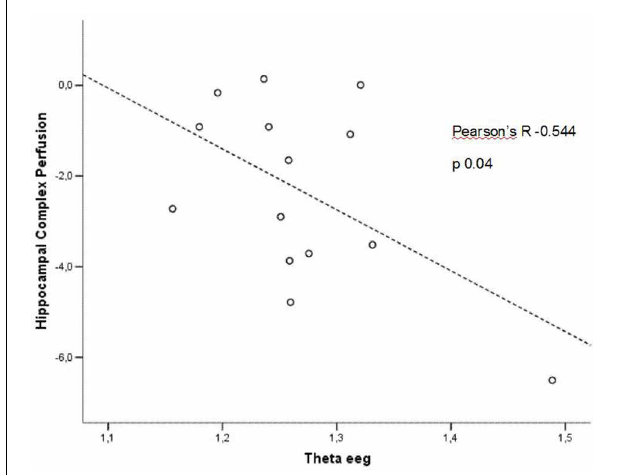
FIGURE 3 | Pearson r correlations between EEG theta rhythm and hippocampal complex perfusion in patients at low risk to develop AD.